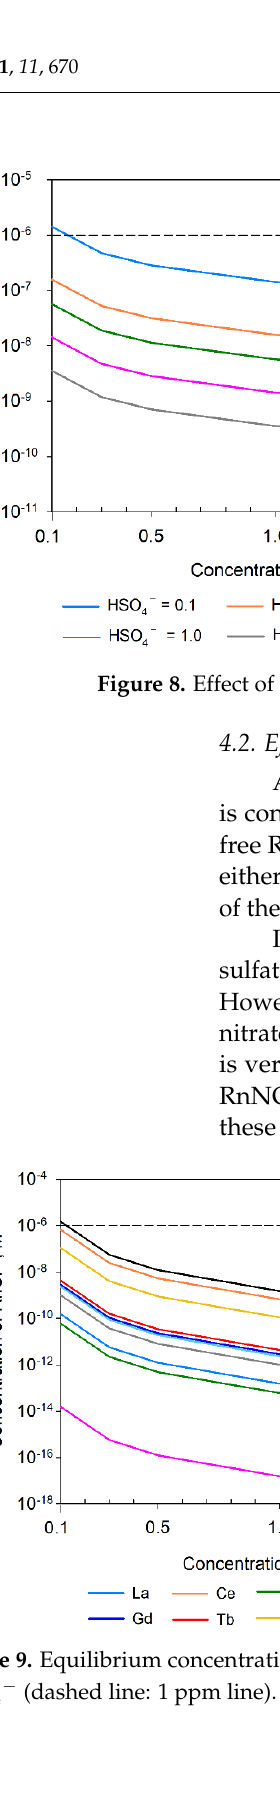
Figure 9. Equilibrium concentrations of ( a ) RnCl 2+ or ( b ) RnNO 32+ in equilibrium with sodium double salt at pH 1 with HSO 4 − (dashed line: 1 ppm line).